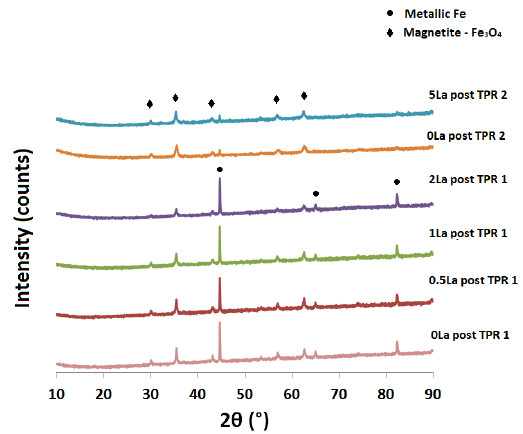
Figure 4. XRD of catalysts after temperature-programmed reduction treatments (TPR 1 and TPR 2). Metallic Fe is the major form of iron in samples after TPR 1. The peaks for metallic Fe are less intense for samples after TPR 2.